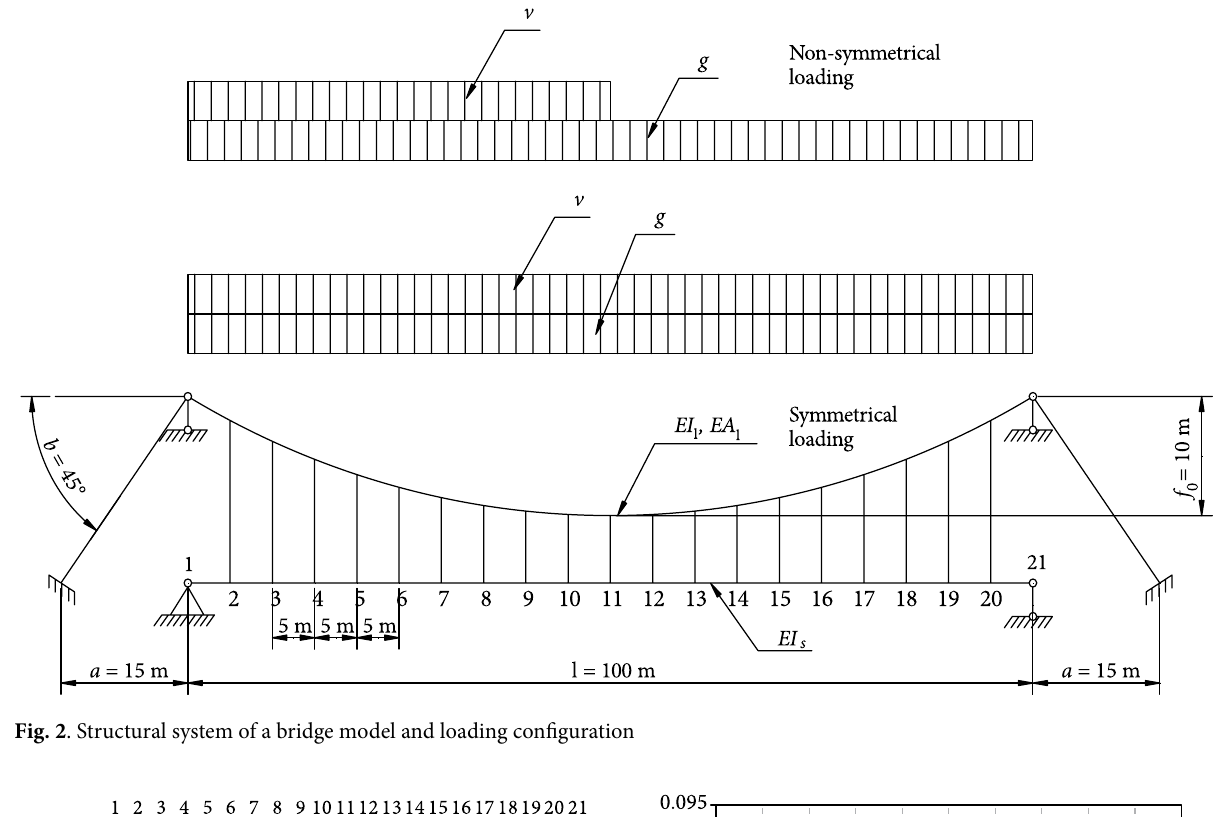
Fig. 2 . Structural system of a bridge model and loading configuration